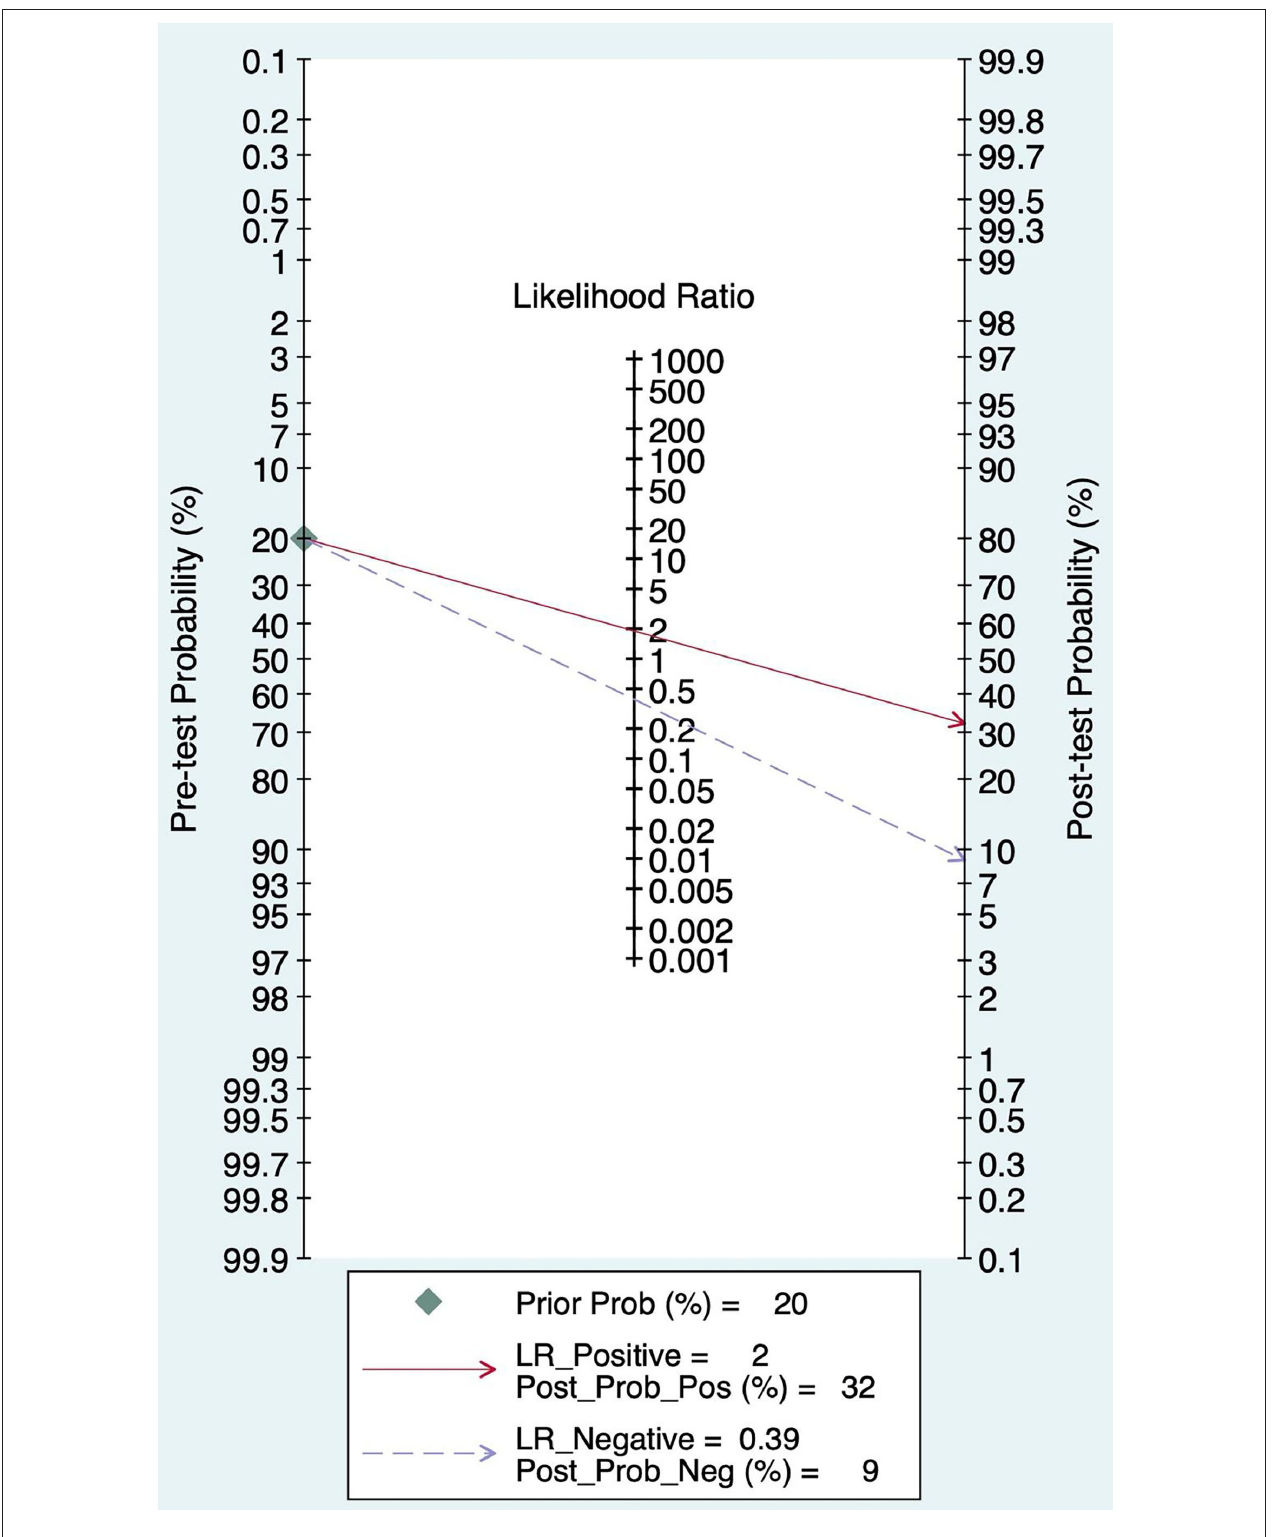
FIGURE 6 | Fagan diagram of FAST in the diagnosis of